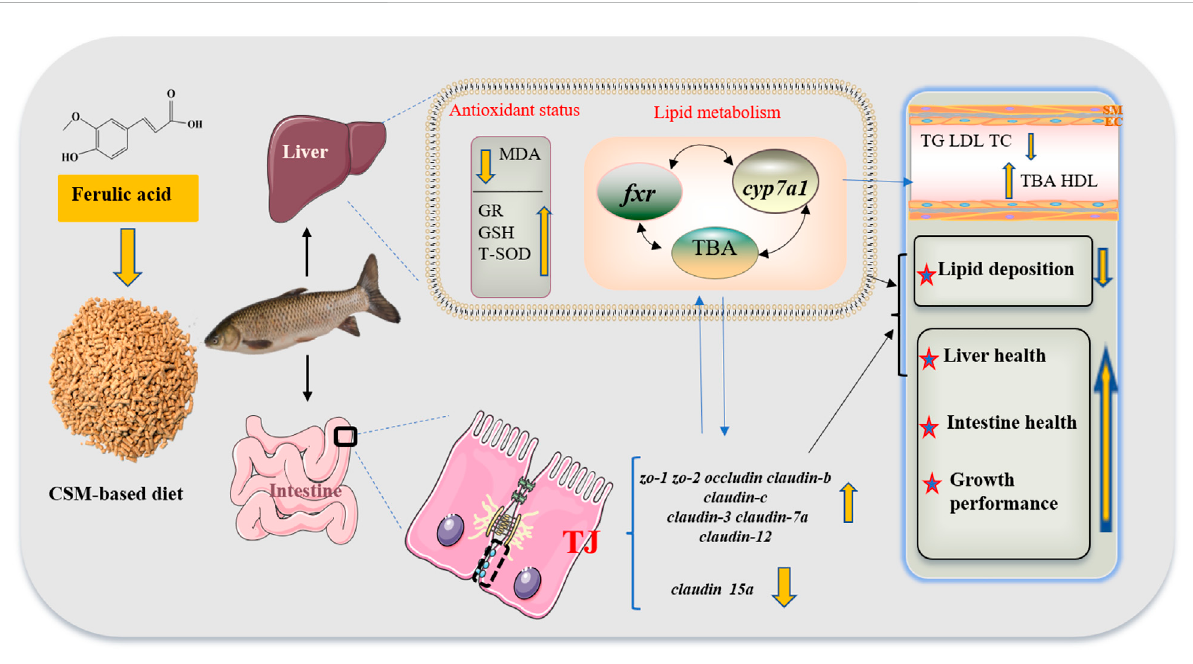
FIGURE 6 Schematic of the bene fi cial effects of optimal FA supplementation in CSM-based diets on lipid metabolism, antioxidant status, and growth performance of juvenile grass carp. Abbreviations: cottonseed meal (CSM), malondialdehyde (MDA), glutathione reductase (GR), glutathione